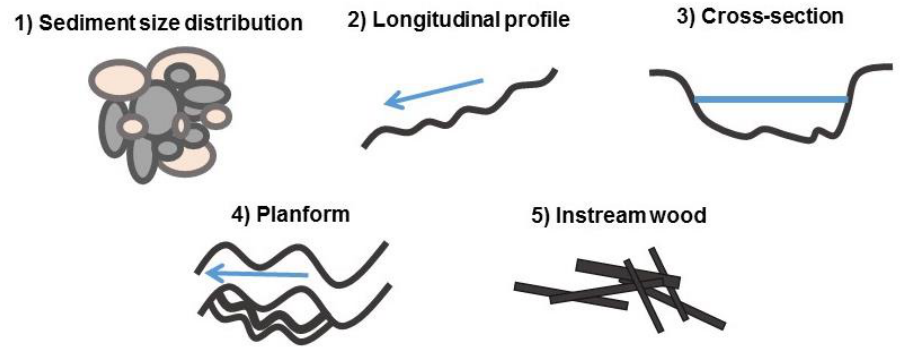
Figure 1. Graphical descriptions of the five dimensions of geomorphic complexity used to get a holistic view of the effect of restoration across a gradient of restored and potential complexity. Eight sediment size distribution (1) metrics were calculated from data collected using a “pebble count” of 300 sediment grains. Longitudinal profile (2) is basically how the stream looks as it flows downstream from the side (profile view of a stream shown here); seven metrics were calculated that describe the complexity of the longitudinal profile. The two cross-section (3) metrics describe the complexity of the stream as if one took a slice of a bread loaf, e.g., measuring the complexity of the stream bottom compared to bankfull width. The six planform (4) metrics describe the complexity of the stream as seen from above. Six metrics of instream wood (5) describe the complexity of naturally recruited and restored wood in the stream. From these 29 metrics, 14 were used in the final analysis.